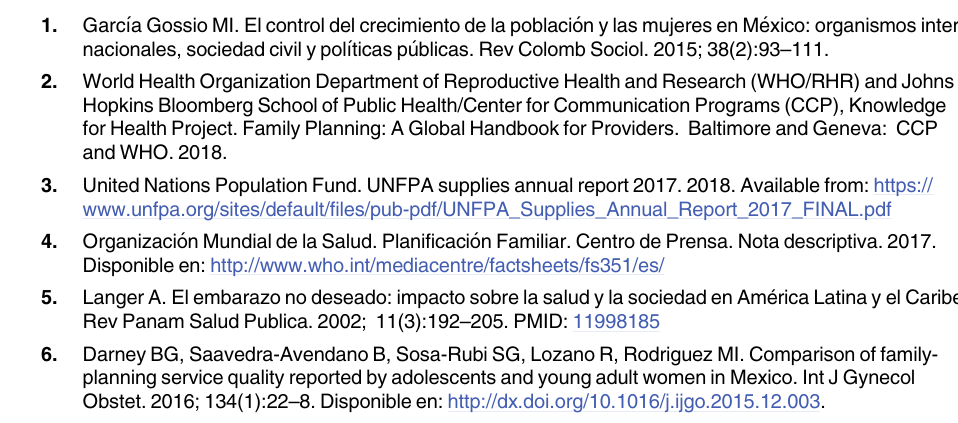
S1 Fig. Dimensions for evaluating the quality of family planning services. Source: Elabo- rated by the authors based on the conceptual frameworks of Bruce-Jain [29–31], Creel [26] and Donabedian